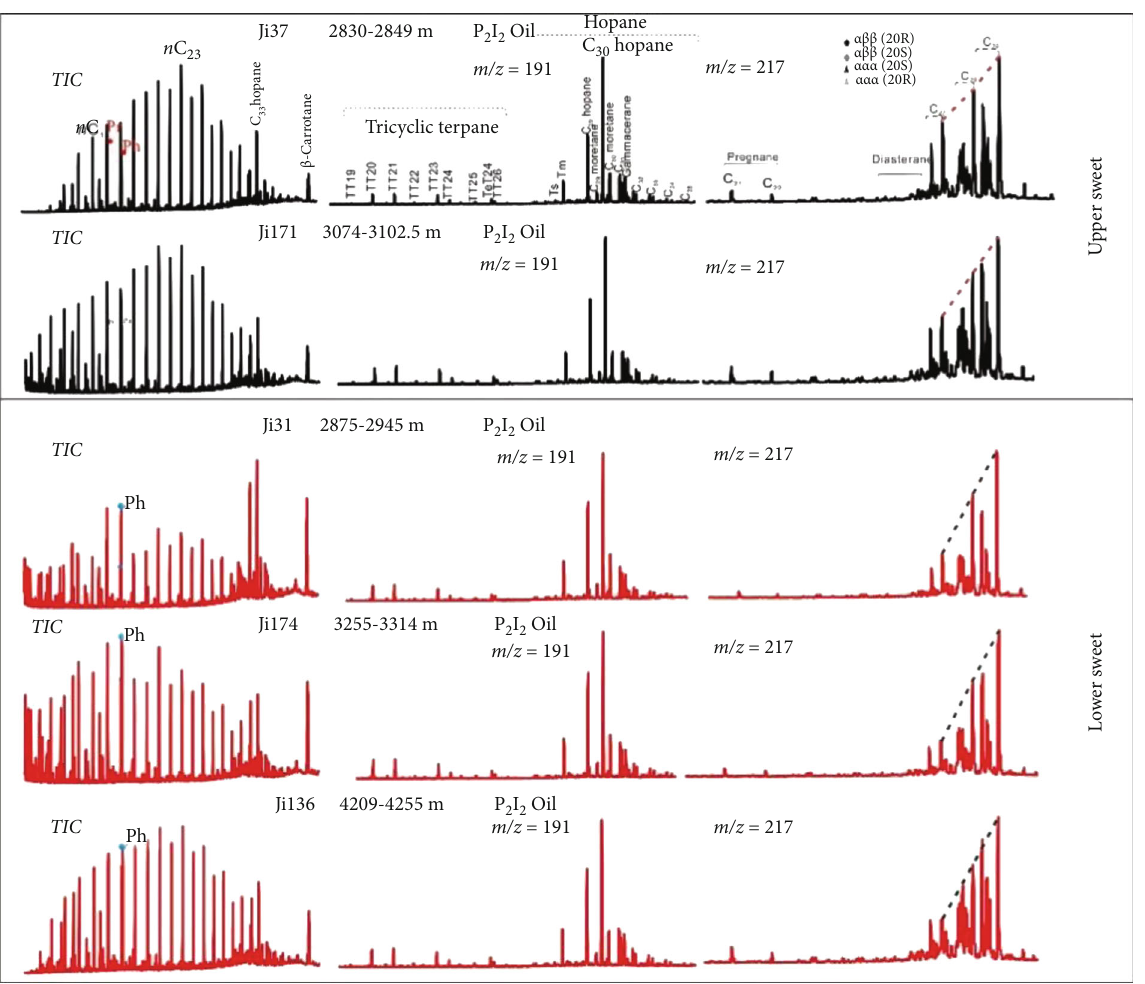
Figure 6: Gas chromatography (GC) and gas chromatography-mass spectrometry (GC-MS) data for the crude oil in the Lucaogou Formation, Jimusaer